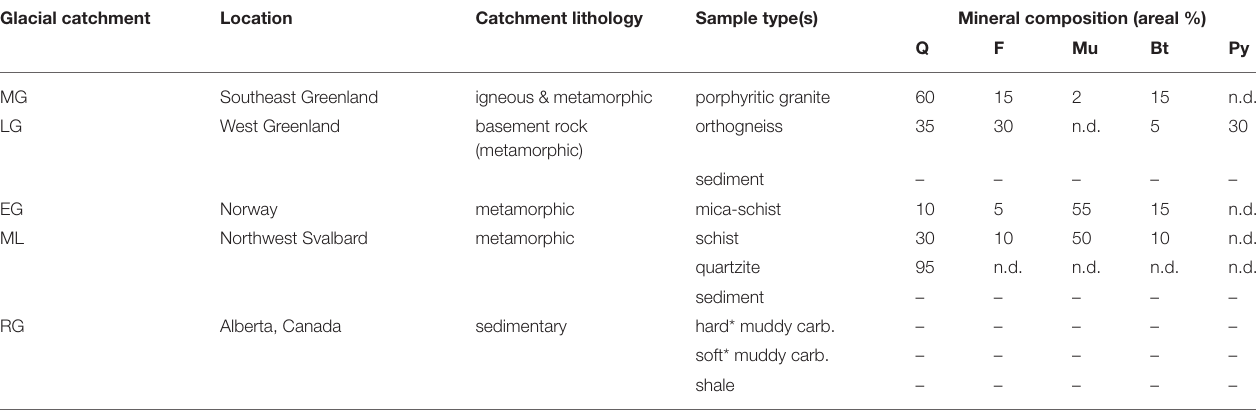
TABLE 1 | Characteristics of the rock and sediment samples and their source glacial catchments, with estimates for the crystalline rock samples of the areal percentage of major rock forming minerals, quartz (Q), feldspar (F), muscovite mica (Mu), biotite mica (Bt) and pyroxene (Py) (NB totals may not be 100 % where other minerals were